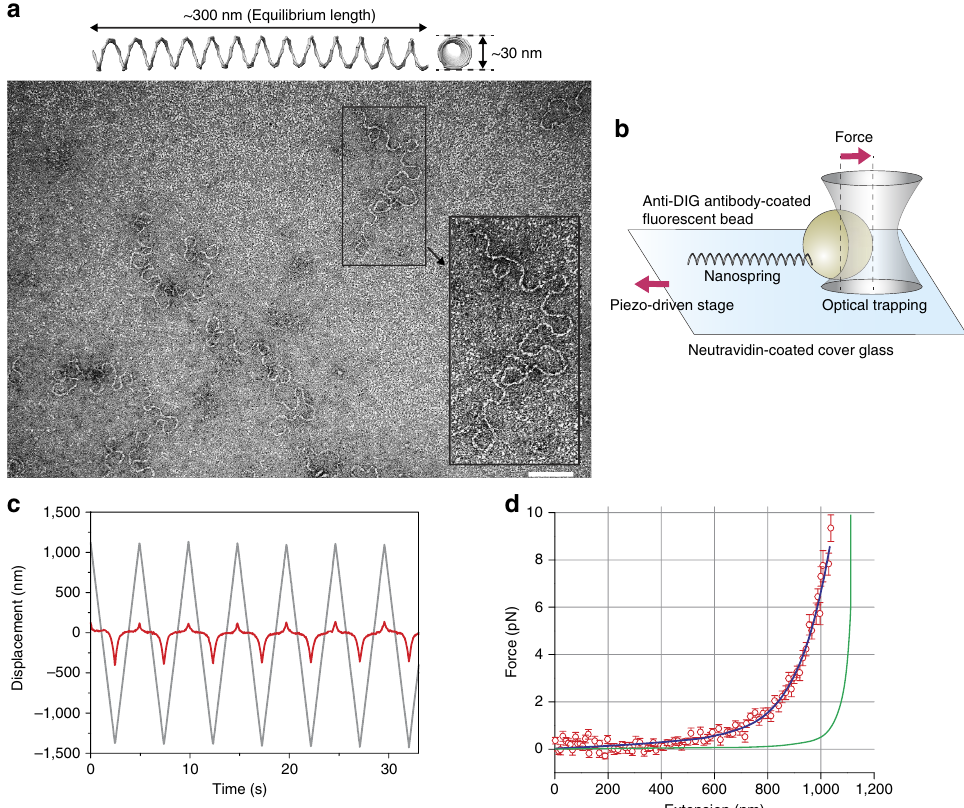
Figure 1 | Programmable DNA origami nanospring and the force-extension curve. ( a ) Upper: the three-dimensional structure of a two-helix bundle (2HB) nanospring produced by CanDo 43 , which predicted a coil structure (13 turns, B 30nm in diameter and B 300nm in equilibrium length). Lower: a transmission electron microscopy image of a nanospring folded in 14mM MgCl 2 . Inset: expanded view of a typical nanospring. The shape was flexible enough to measure single myosin VI force but also showed expected loops. Scale bar, 100nm. ( b ) Experimental setup for the OT assay. A 200nm fluorescent bead tagged with a nanospring (bead-NS) was optically captured and the cover glass was then moved by a piezo actuator. ( c ) Trajectory of the bead (red line) and fix point of the 2HB nanospring on the cover glass (grey line). See also Supplementary Movie 1. ( d ) Averaged force-extension curve for the 2HB nanospring. N ¼ 19. Error bars represent s.d. Blue line, fitted curve by a seventh-order polynomial. Green curve indicates a theoretical curve for a single dsDNA assuming a modified Marko–Siggia worm-like chain model 26